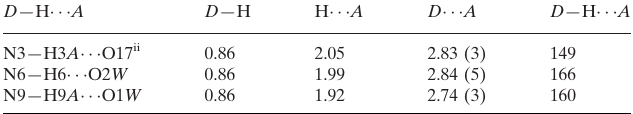
Hydrogen-bond geometry (A˚ , (cid:4)